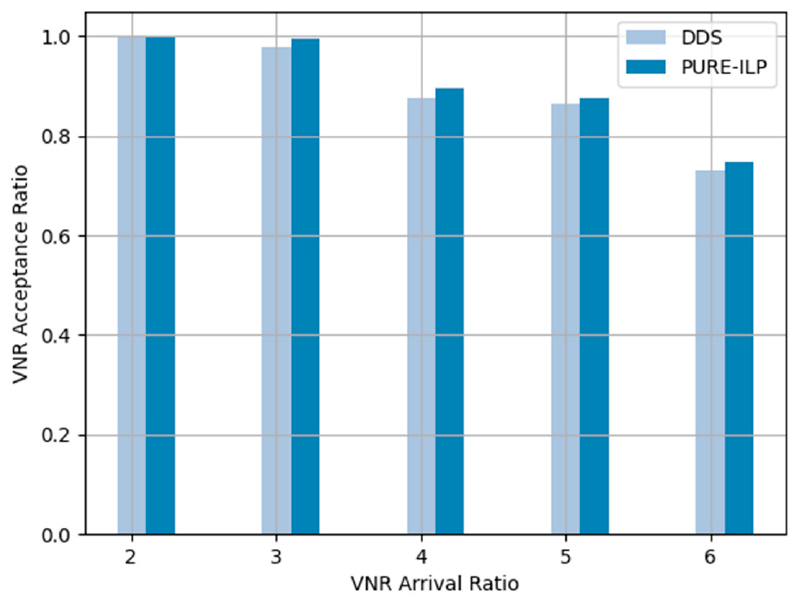
Figure 10. Comparison of DDS with PURE-ILP under various VNR arrival ratios.